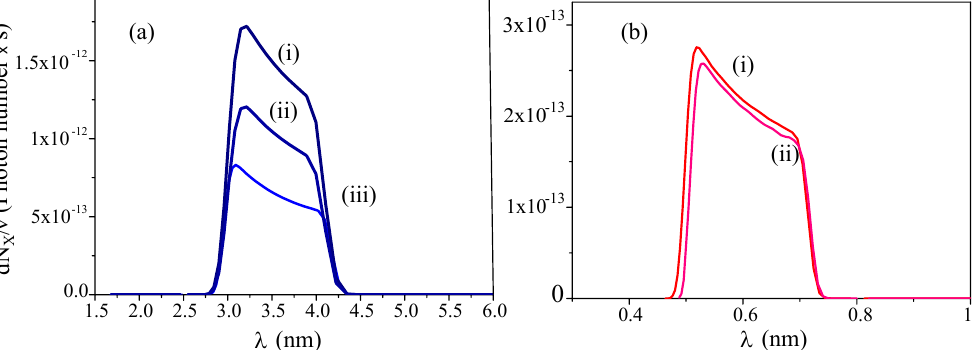
Figure 13. Spectrum of the collimated X-ray radiation for a bandwidth of 10%. Window ( a ): λ X = 3 nm, (i) λ w = 3.5 cm, λ THz = 36 µ m; (ii) λ w = 4.5 cm, λ THz = 36 µ m; (iii) λ w = 4.5 cm, λ THz = 51.6 µ m. Window ( b ): λ X = 0.5 nm, (i) λ w = 3.5 cm, λ THz = 13.2 µ m; (ii) λ w = 4.5 cm, λ THz = 15 µ